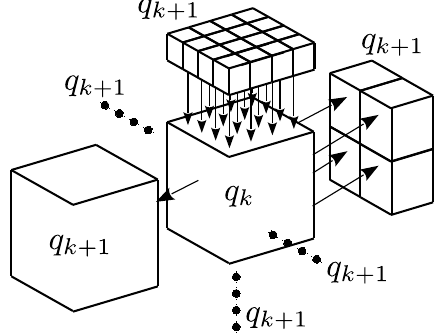
Figure 4. Neighbourhood structure. Octree decomposition